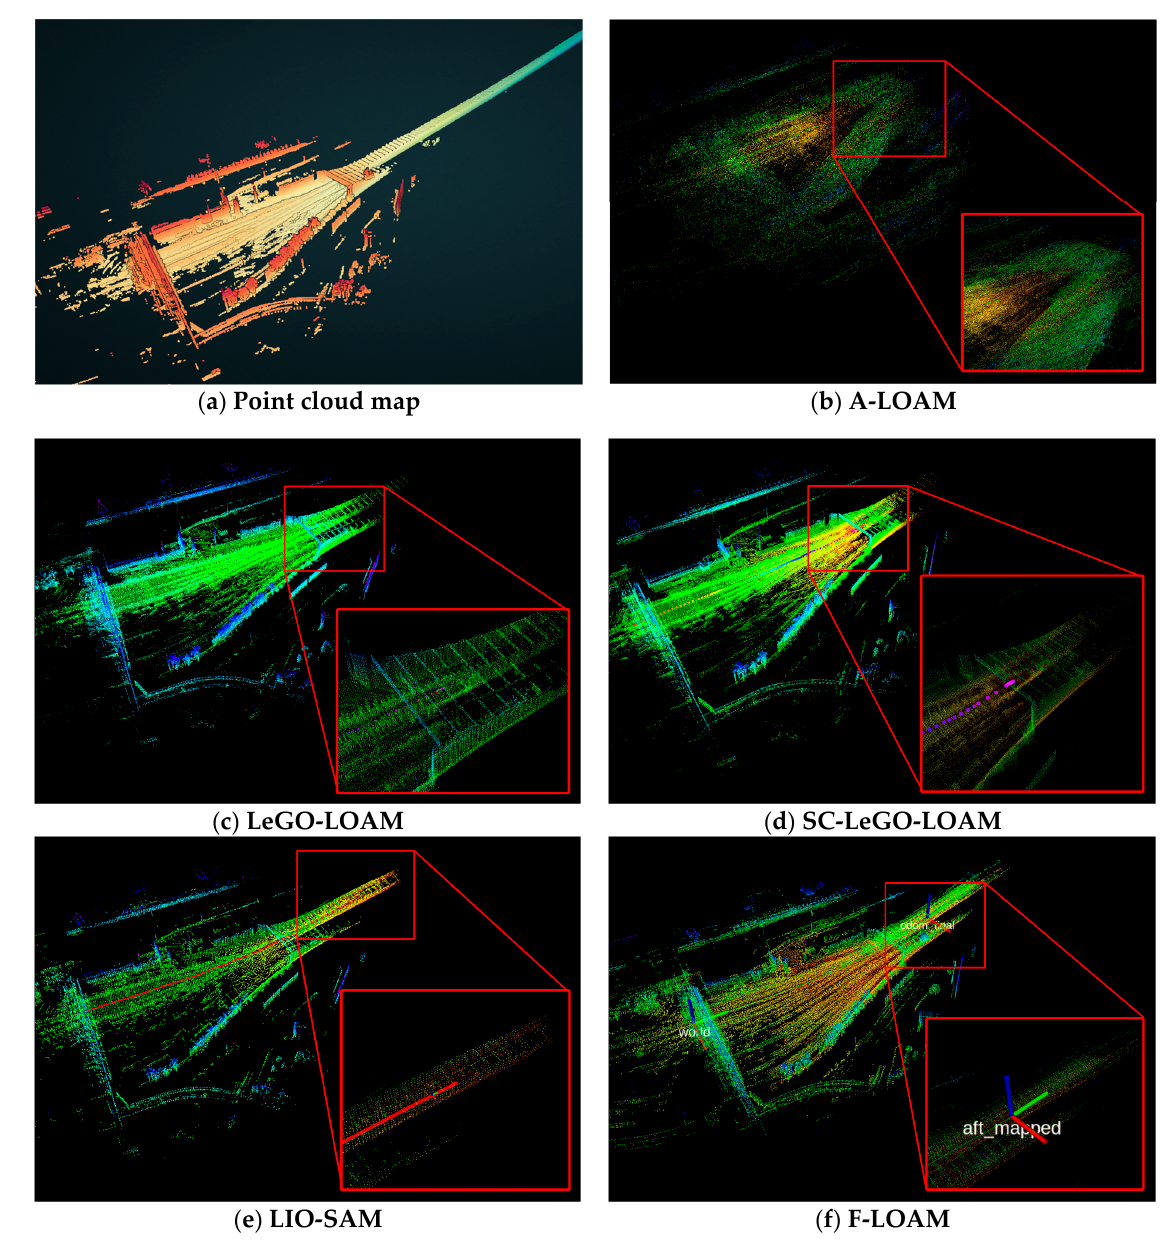
Figure 11. The mapping effect of different algorithms in the tunnel and where the degradation occurs. ( a ) The actual point cloud map given by the dataset. ( b ) Result of A-LOAM. ( c ) Result of LeGO-LOAM. ( d ) Result of SC-LeGO-LOAM. ( e ) Result of LIO-SAM. ( f ) Result of F-LOAM. The exact location where the degradation occurs is zoomed in so that the mapping effect and the effective distance of the odometer can be accurately compared.